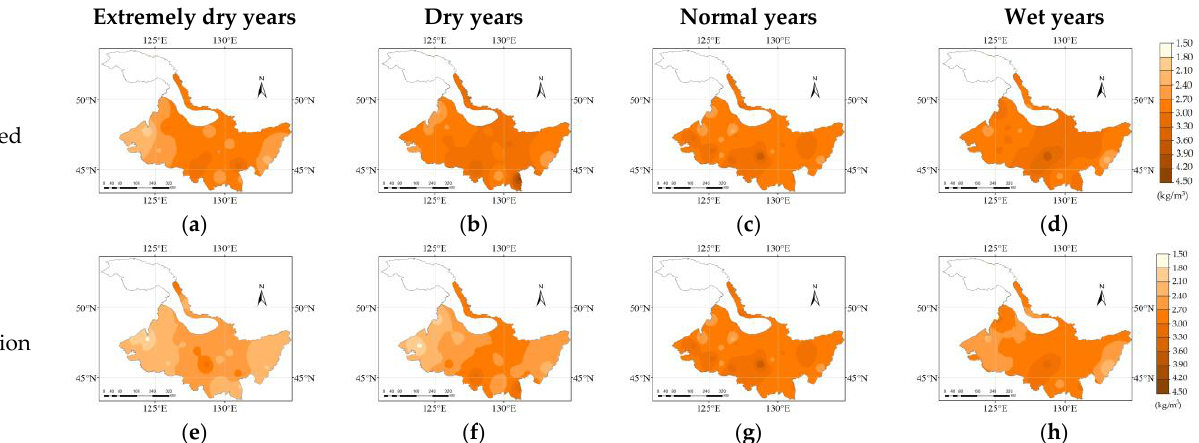
Figure 9. Spatial distribution of WUE in extremely dry years ( a , e ), dry years ( b , f ), normal years ( c , g ), and wet years ( d , h ) under the rainfed and irrigation scenarios.